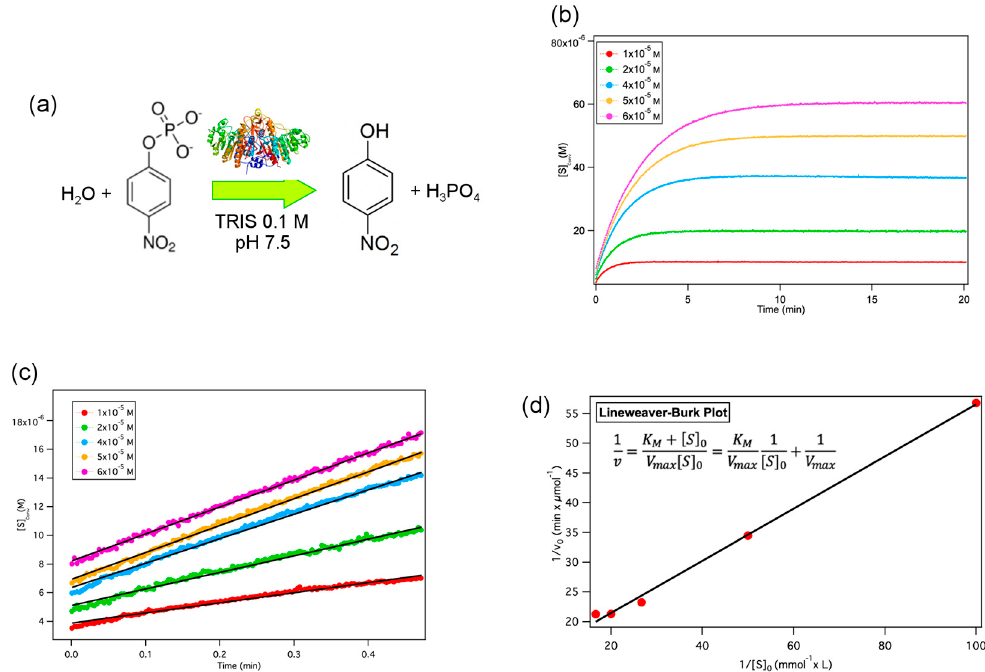
Figure 2. Reaction kinetics in solution. ( a ) Sketch of the AP-catalysed reaction of p-nitrophenyl phosphate conversion into p-nitrophenol; ( b , c ) reaction kinetics followed through UV–vis spectroscopy at 400 nm, varying the concentration of substrate (1 × 10 − 5 M (red), 2 × 10 − 5 M (green), 4 × 10 − 5 M (cyan), 5 × 10 − 5 M (yellow) and 6 × 10 − 5 M (purple) in the presence of a fixed amount of enzyme (0.2 U / mL); ( b ) complete conversion kinetics (0–20 min) ( c ) initial conversion kinetics (0.0–0.5 min) analysed with a linear fit (black bold lines) to determine the initial reaction rate; ( d ) Lineweaver–Burk plot of the inverse initial reaction rate vs. the inverse substrate concentration to extract the Michaelis–Menten constant and the maximum velocity; the error bars in the graph are smaller than the markers’ size.